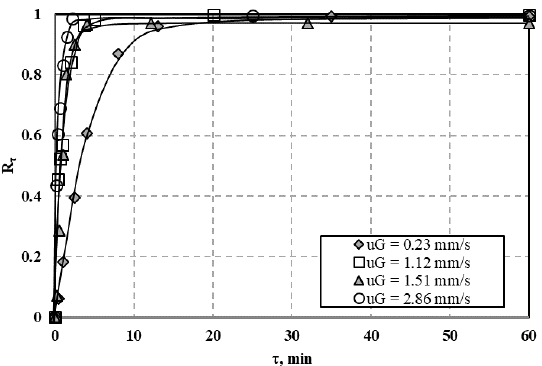
Figure A26. Changes in Cu(II) temporary removal ratio during precipitate flotation from solution containing Al(III), Cu(II), and Zn(II) mixture—effect of air velocity (c 0 = 2 mmol dm − 3 , pH = 8.7, c SDS = 0.187 mmol dm − 3 ).